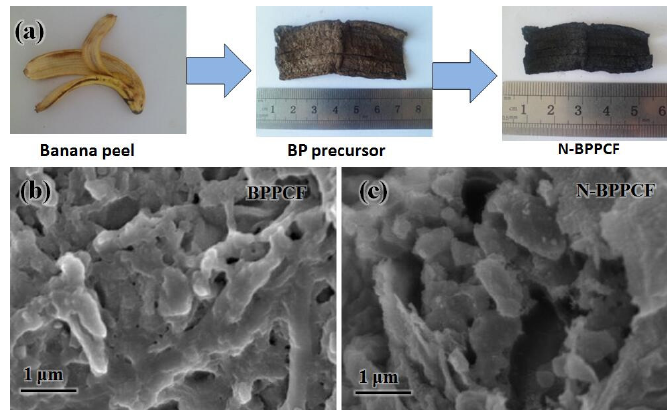
Figure 1. ( a ) Synthesis of porous carbon foam from banana peels. Scanning electron microscopy (SEM) images of ( b ) banana peel-derived porous carbon foam (BPPCF) and ( c ) nitrogen-doped BPPCF (N-BPPCF).